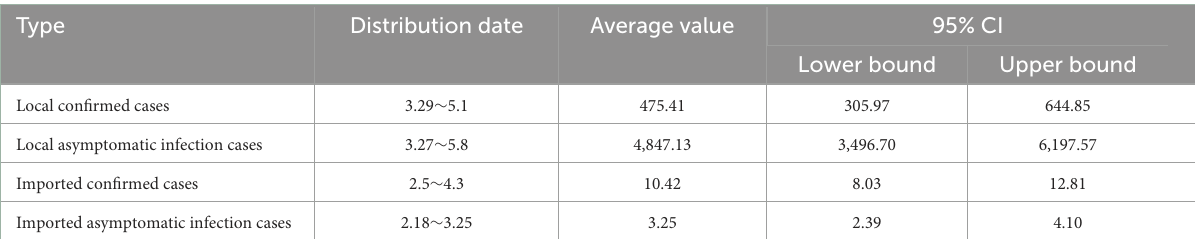
TABLE 1 Distribution analysis of daily new incidences of four types of